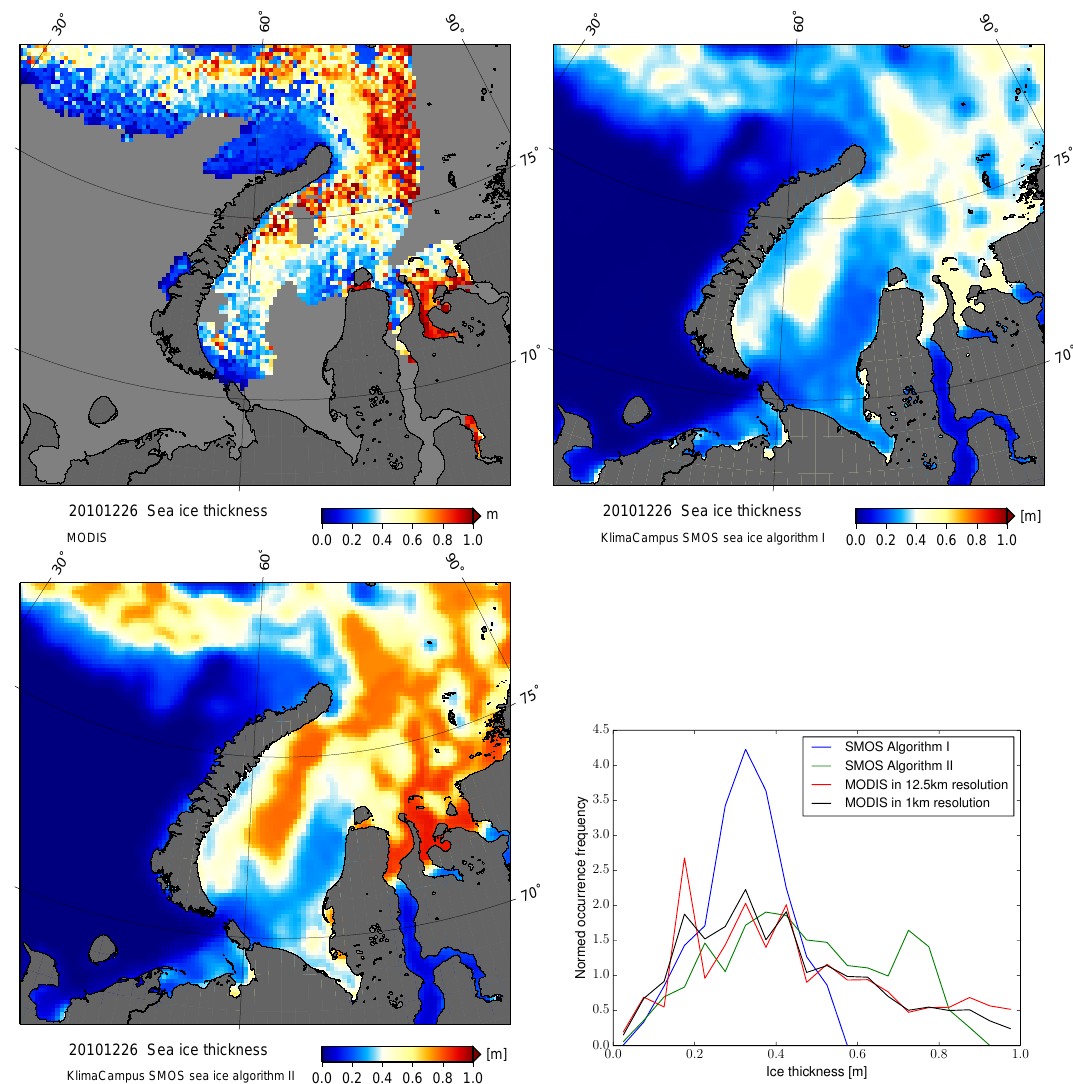
Figure 16. The modal MODIS ice thickness with 12.5km grid resolution (upper left), SMOS ice thicknesses retrieved from Algorithm I (upper right) and II (lower left), and the histogram of the three ice thickness data (lower right) in the Kara Sea on 26 December 2010.